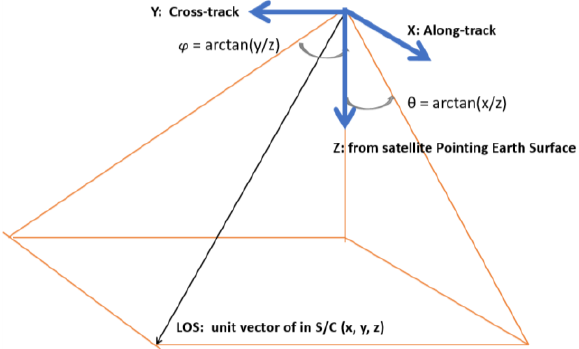
Figure 6. The OMPS LOS vector is expressed in the spacecraft coordinate, where the along-track ( x-z plane) and cross-track planes ( y - z plane) are formed. Two angles of θ and φ simultaneously correspond to the unit vector of LOS .